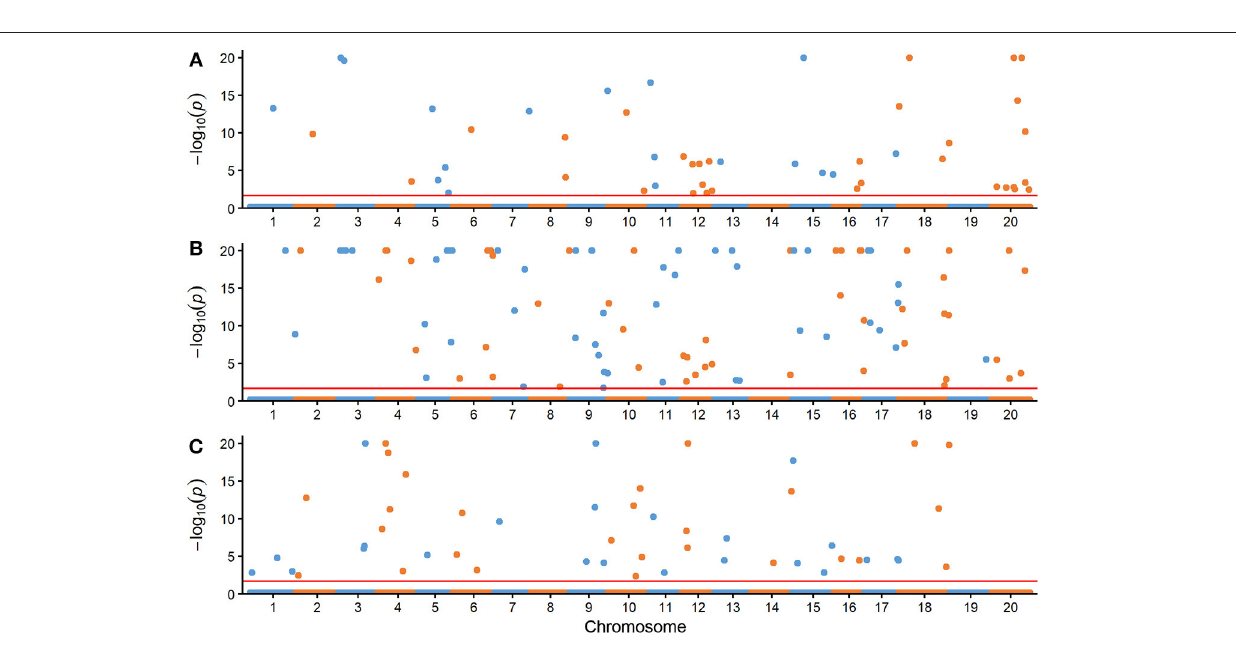
can be organized into 136 × 366, 283 × 366, and 154 × 366 (allele × accession) matrices which were designated as QTL- allele matrix of SOC, OAC, and LAC of CSLRP,